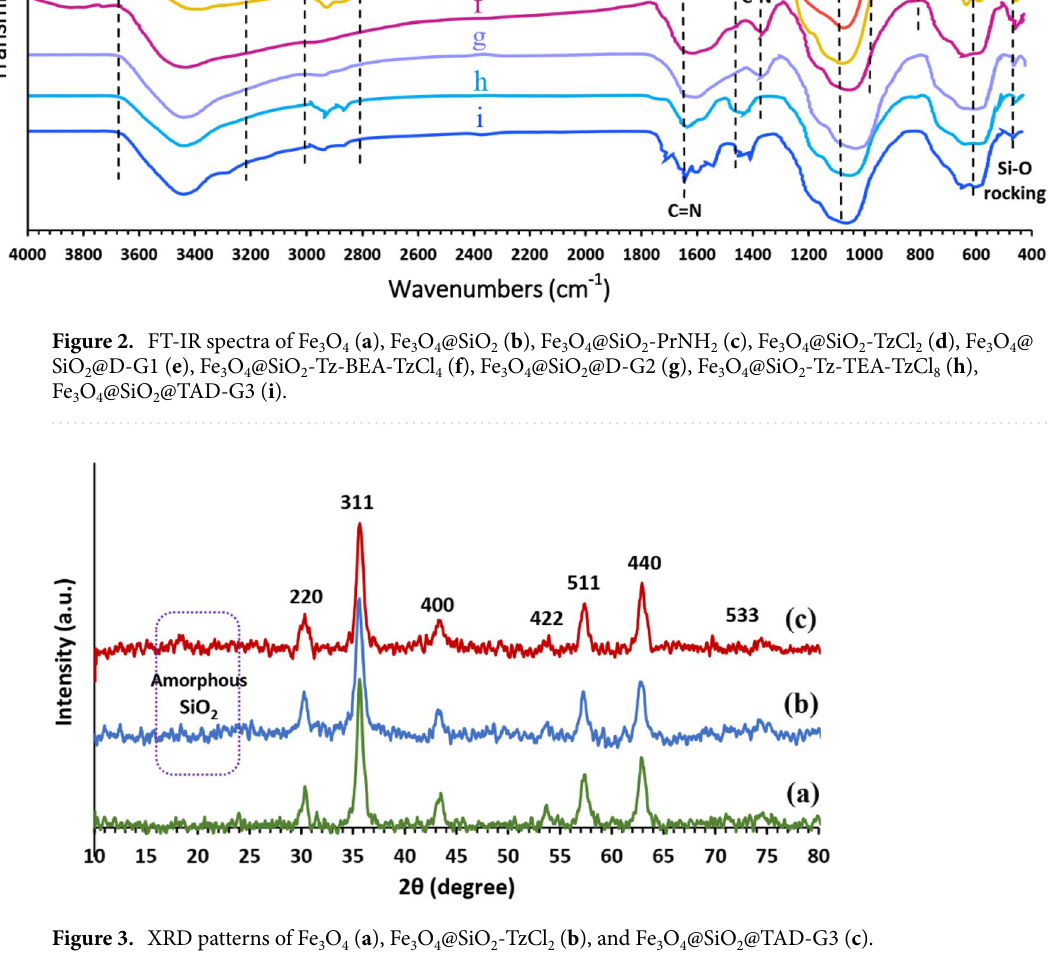
Figure 3. XRD patterns of Fe 3 O 4 ( a ), Fe 3 O 4 @SiO 2 -TzCl 2 ( b ), and Fe 3 O 4 @SiO 2 @TAD-G3 ( c